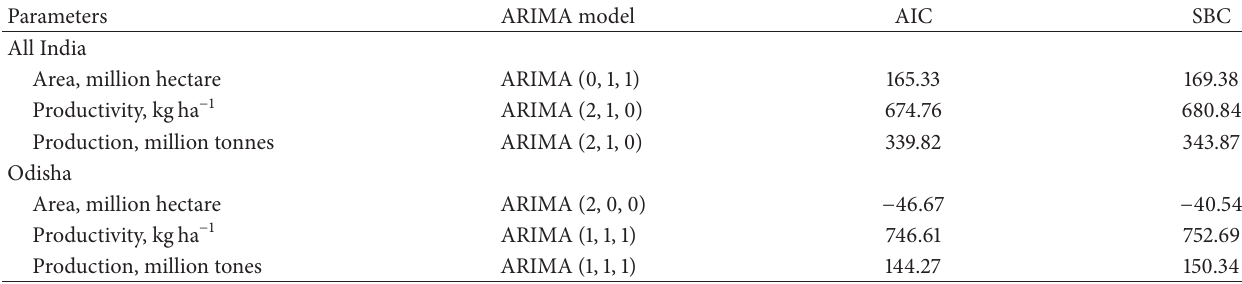
Table 2: Autoregressive integrated moving average (ARIMA) models fitted for time series data on rice area, productivity, and corresponding selection criterion, that is, Akaike information criteria (AIC) and Schwarz-Bayesian information criteria (SBC).